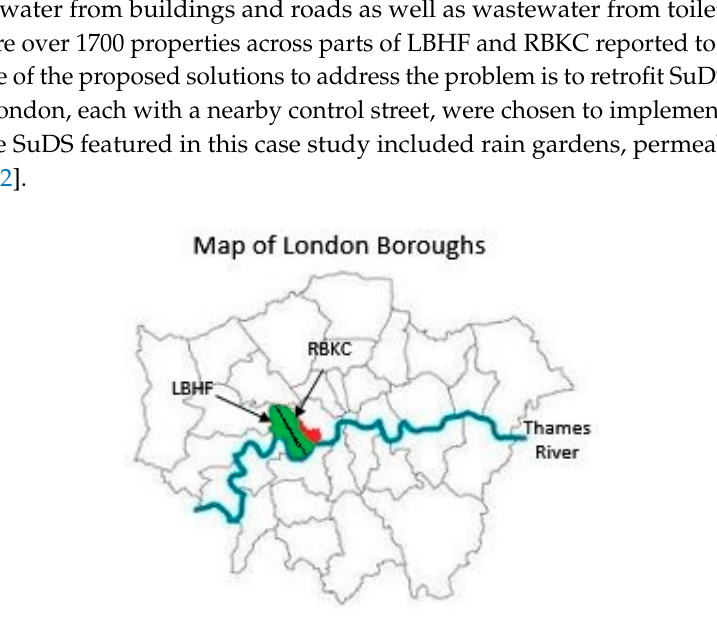
Event based / continuous simulation Very Complex